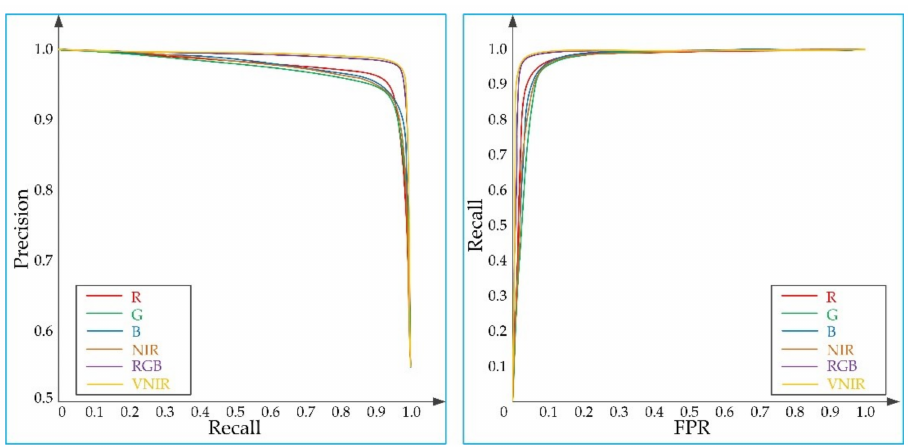
Figure 8. Comparison curves of different bands. ( a ) PR curve; ( b ) ROC curve.